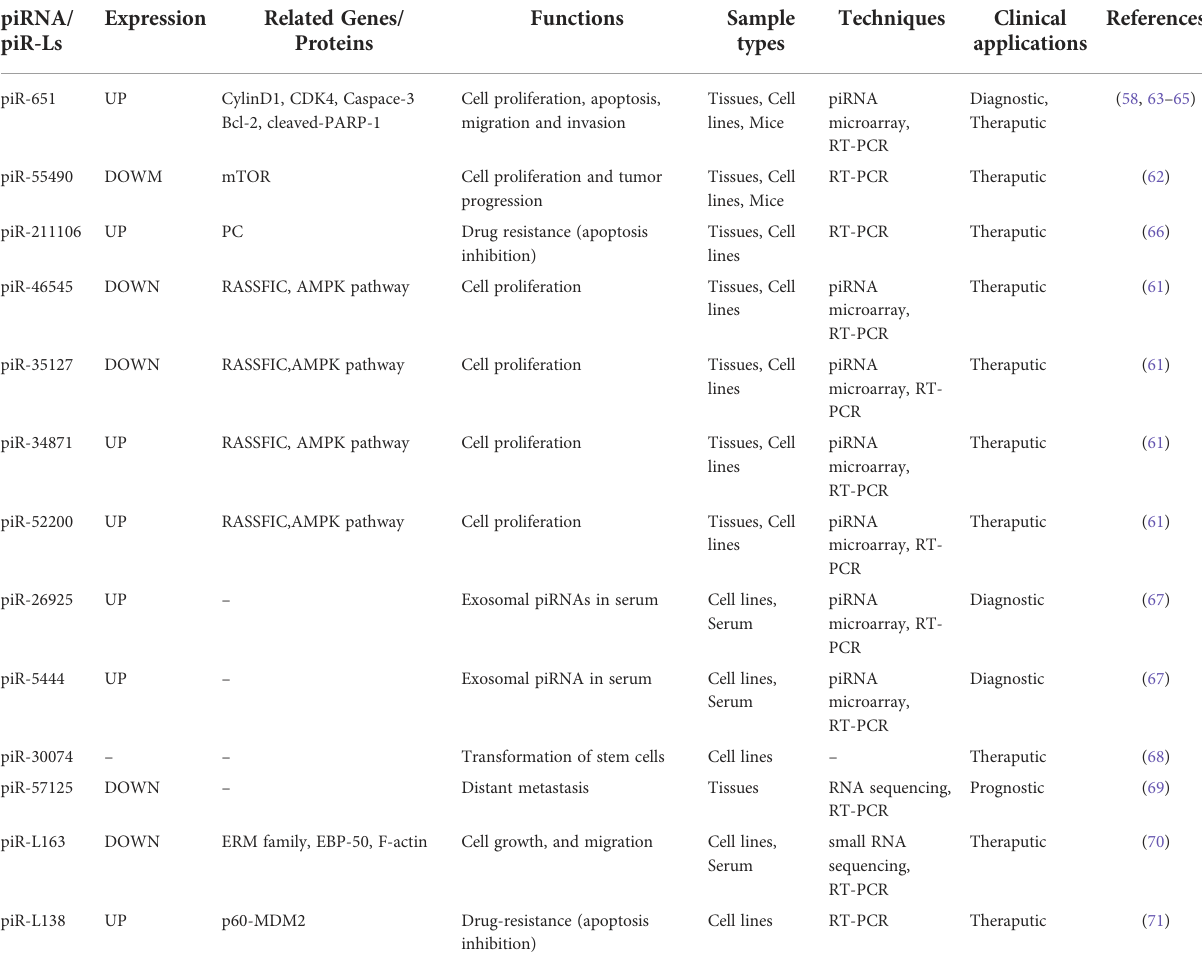
TABLE 1 Research reporting altered piRNA expression in lung